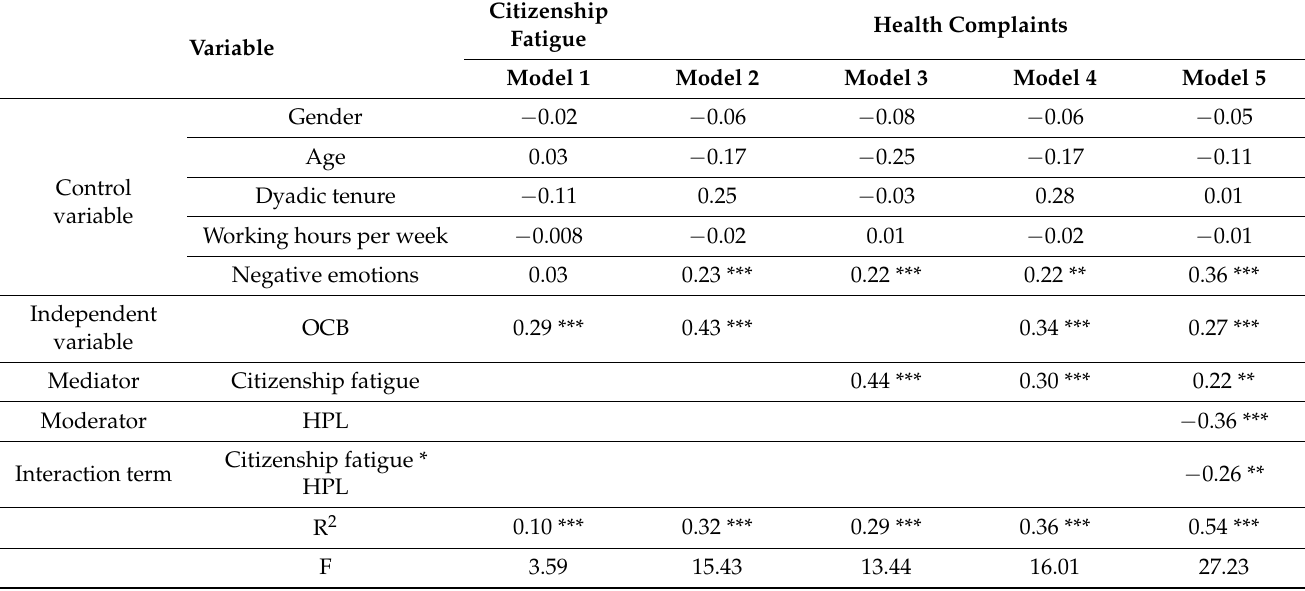
Table 3. Mediating role of citizenship fatigue and moderating effect of